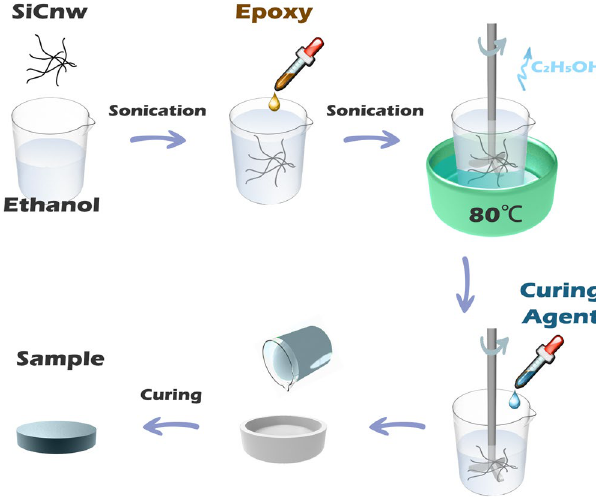
Figure 1. The preparation process of epoxy/SiC NWs